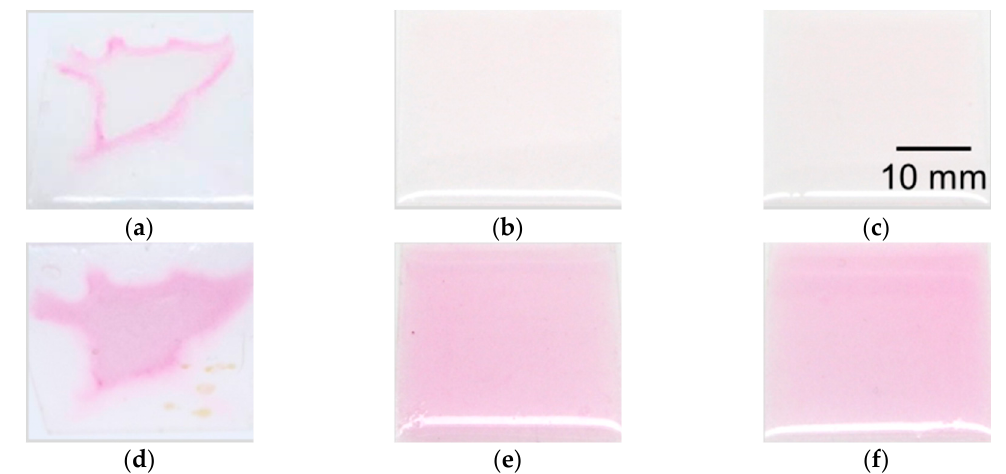
Figure 4. Fabricated membrane samples of the composite material with PVA coating. Samples after immersion in acetone for 1 h with PVA thickness of ( a ) 23 µm, ( b ) 47 µm, and ( c ) 85 µm. Samples after being heated at 90 °C for 1 h with PVA thickness of ( d ) 23 µm, ( e ) 47 µm, and ( f ) 85 µm.